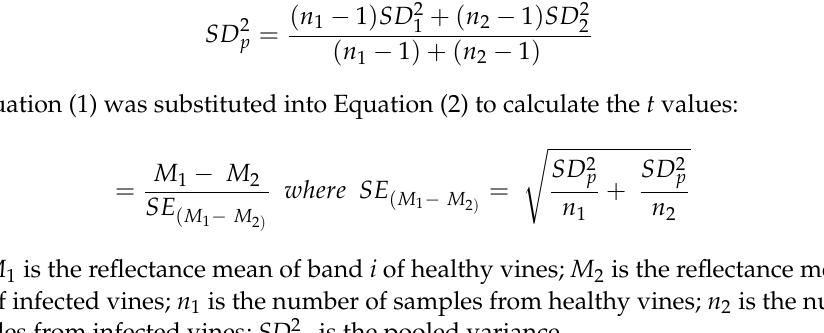
Figure 4. The spectral profile of 10,000 random pixels equally labeled as healthy or GVCV-infected in the training set ( a – e ) and testing set ( f – j ). Spectral data were resampled to ensure balance between the 2 classes.